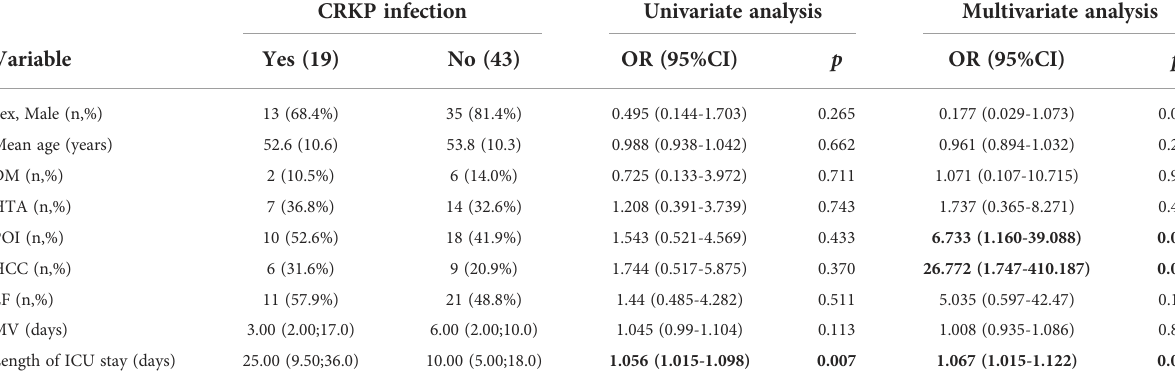
TABLE 6 Univariate and multivariate analysis of the risk of carbapenem-resistant klebsiella pneumoniae infection in liver transplant recipients. CRKP infection Univariate analysis Multivariate analysis